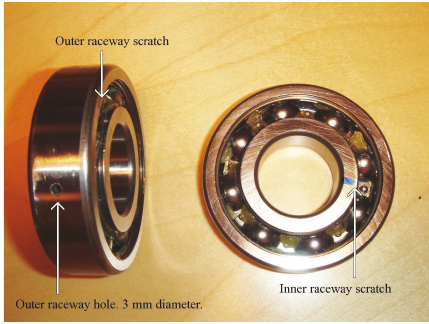
Figure 1: Considered NSK 6305 ball bearings with some artificial inner raceway/outer raceway point defects